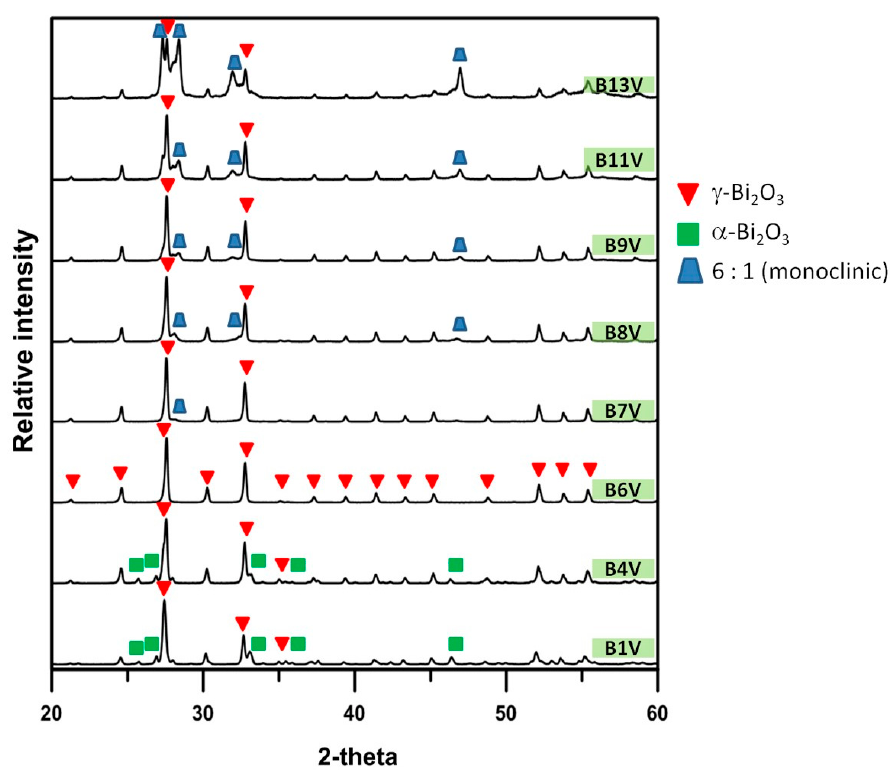
Figure A1. XRD patterns of B1V–B13V die-pressed mixtures, annealed at 600 °C for 100 h.